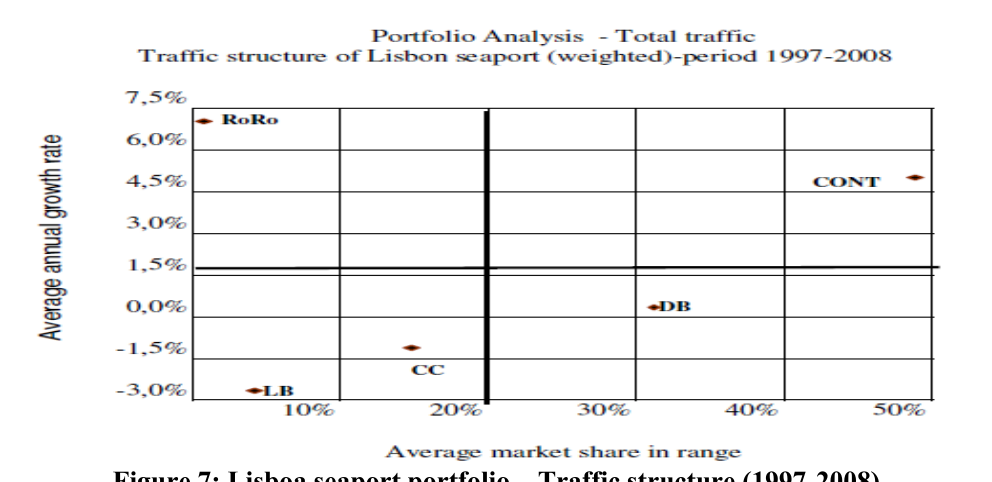
Figure 7: Lisboa seaport portfolio – Traffic structure